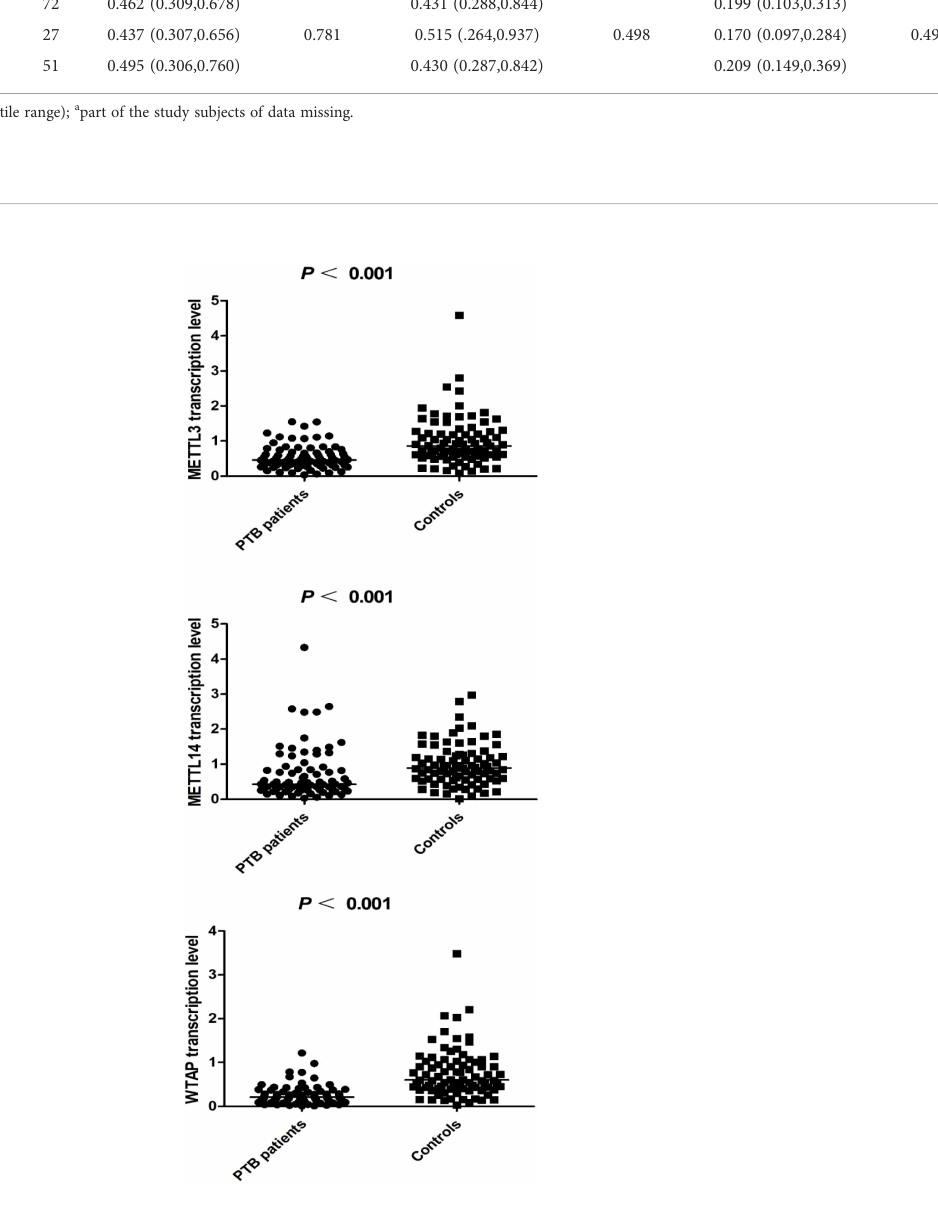
FIGURE 1 The transcription levels of METTL3, METTL14 and WTAP in PTB patients and controls.